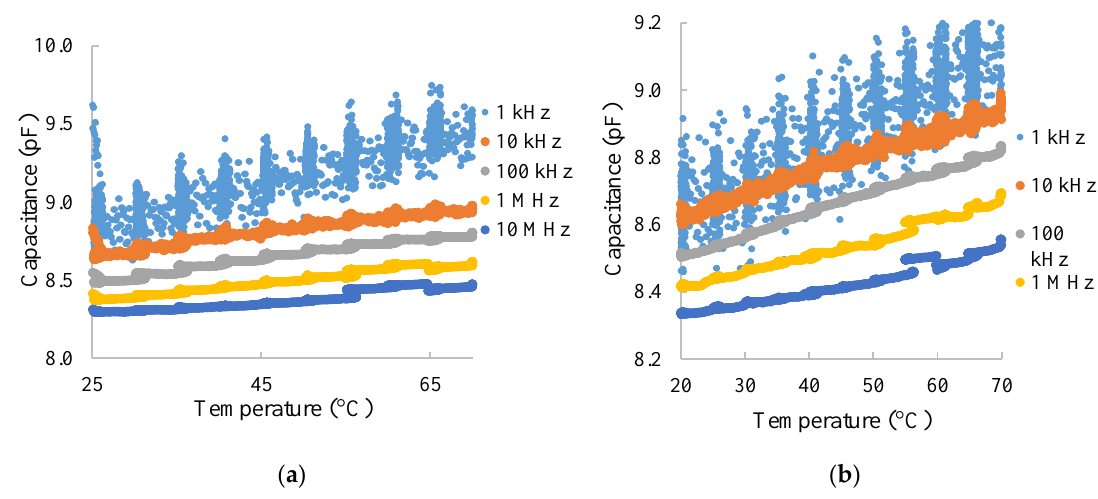
Figure 5. Capacitance vs. temperature at different frequencies and ( a ) 60% RH and ( b ) 40% RH.